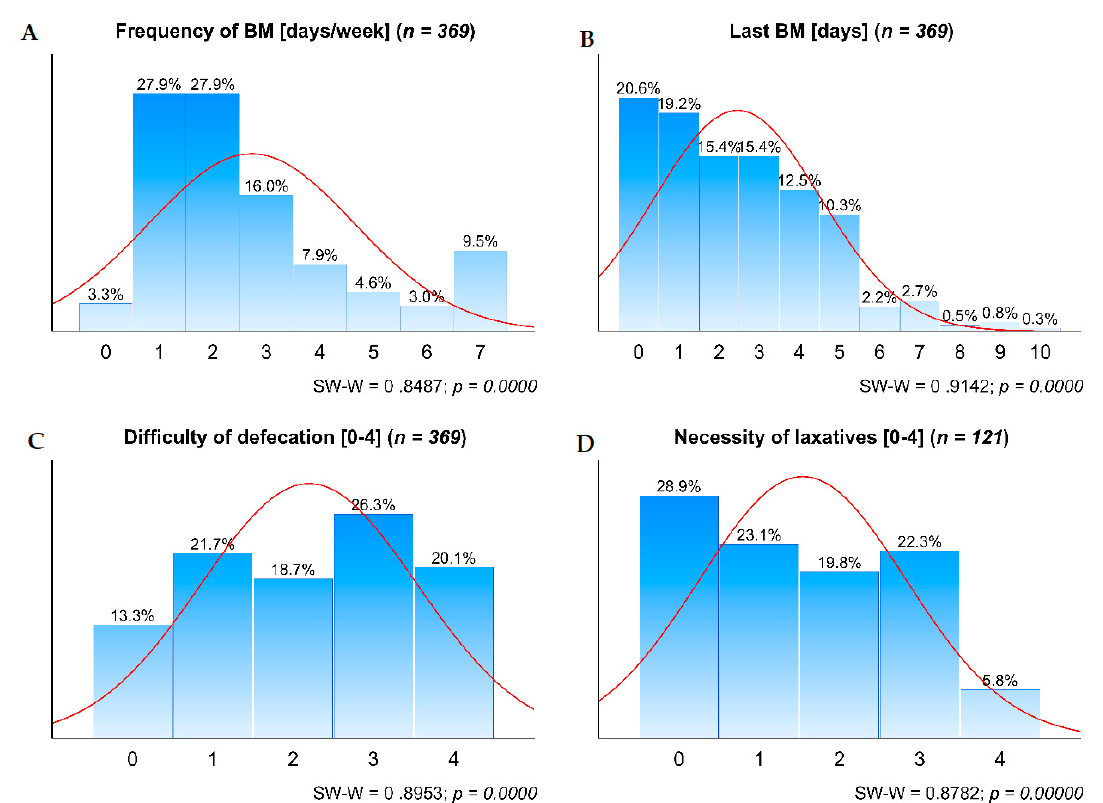
Figure 1. Distribution of the four symptoms of constipation. A . Frequency of BM; B . Last BM; C . Difficulty of defecation; and D . Necessity of laxatives. BM—bowel movements; SW-W—Shapiro-Wilk test for normality